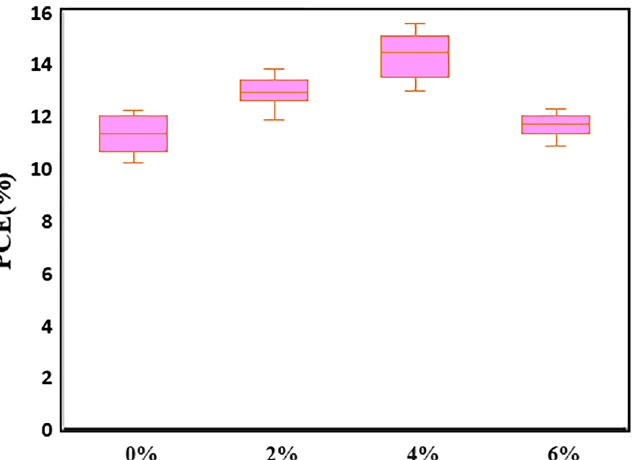
Figure 13. PCE histogram of 32 independent PSCs based on SnO 2 @ZnO.PANI (0%, 2%, 4%, and 6%) nanocomposite as